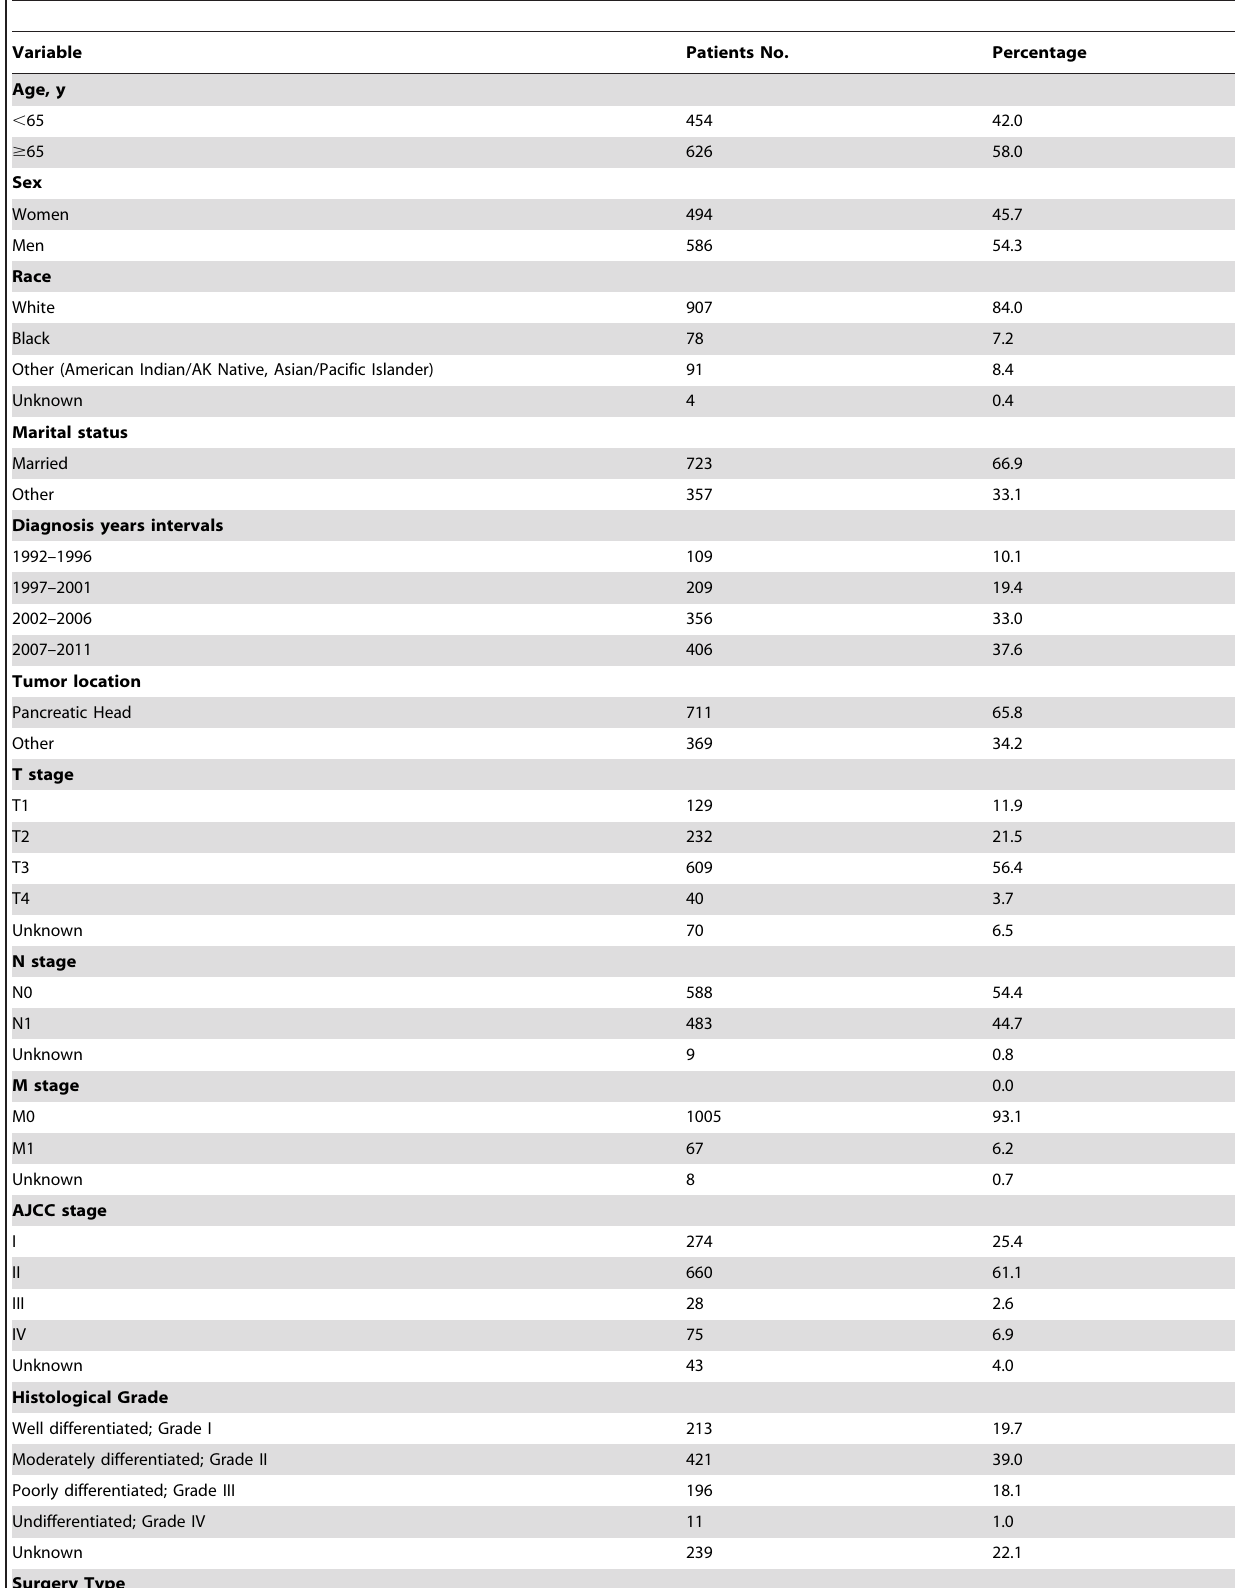
Table 1. Patient, Tumor, and Treatment Characteristics in the Invasive IPMN Patients: Surveillance, Epidemiology, and End Results, 1992 to